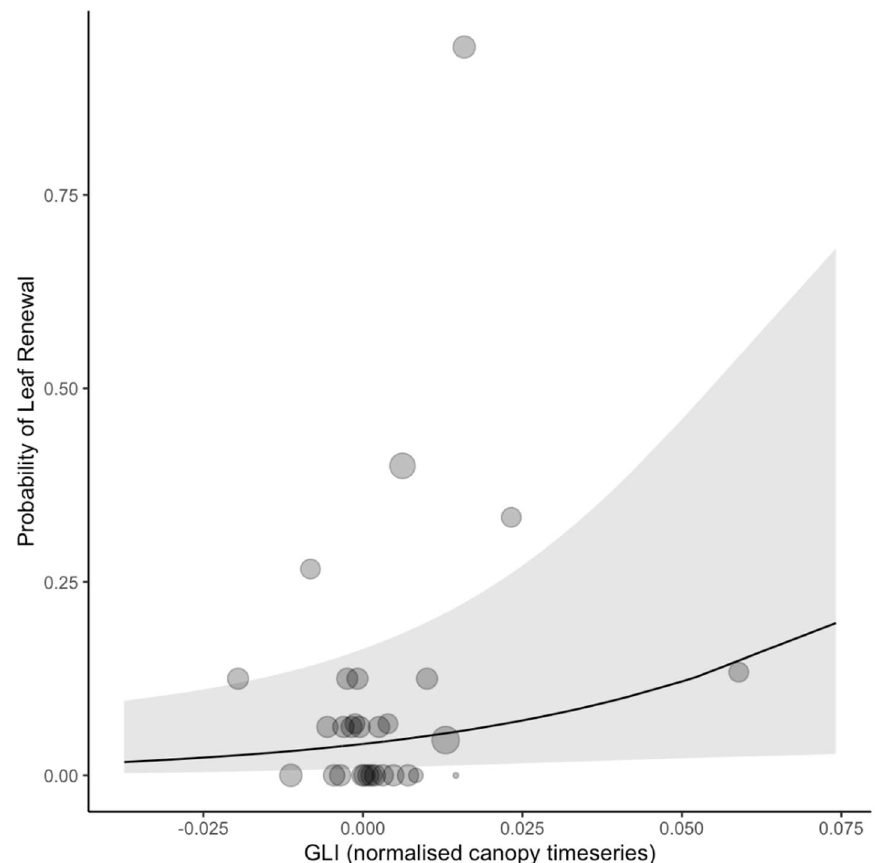
Figure 7. Predicted relationship between Sentinel-2 green leaf index (GLI) canopy deviation and ground observations of Moabi leaf renewal. The solid line shows the fixed effect prediction from the generalized linear mixed model (binomial), the grey ribbon shows the 95% confidence intervals of the prediction, and the translucent dots show the raw data, binned in intervals along the x-axis. Mixed models included tree ID and year as random effects.